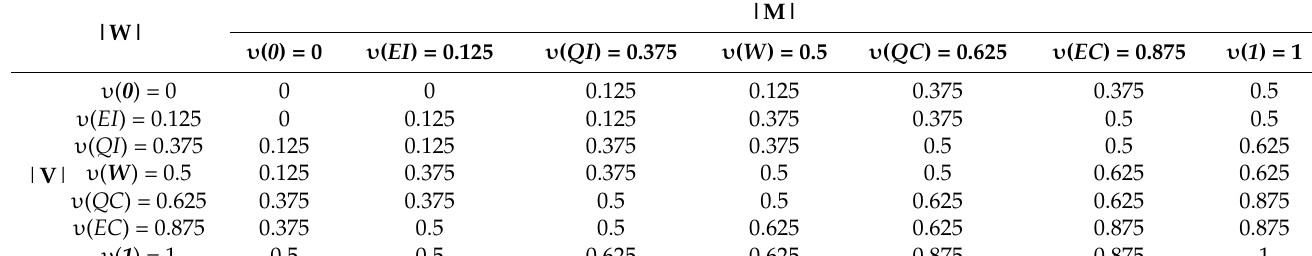
Table 7. The semantic relationship-based rule base of | W |.